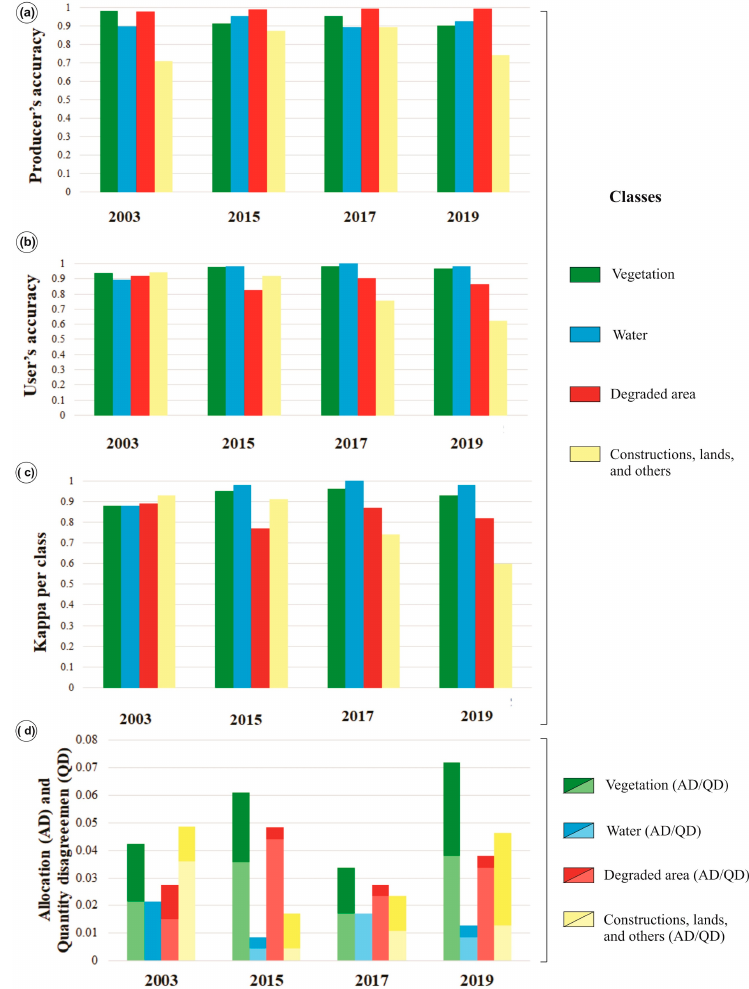
Figure 5. Level 1 accuracy statistics: ( a ) Producer’s and; ( b ) user’s accuracy per class for 2003, 2015, 2017, and 2019 imagery; ( c ) Kappa per class index (Level 1 of classification); ( d ) allocation and quantity disagreements.